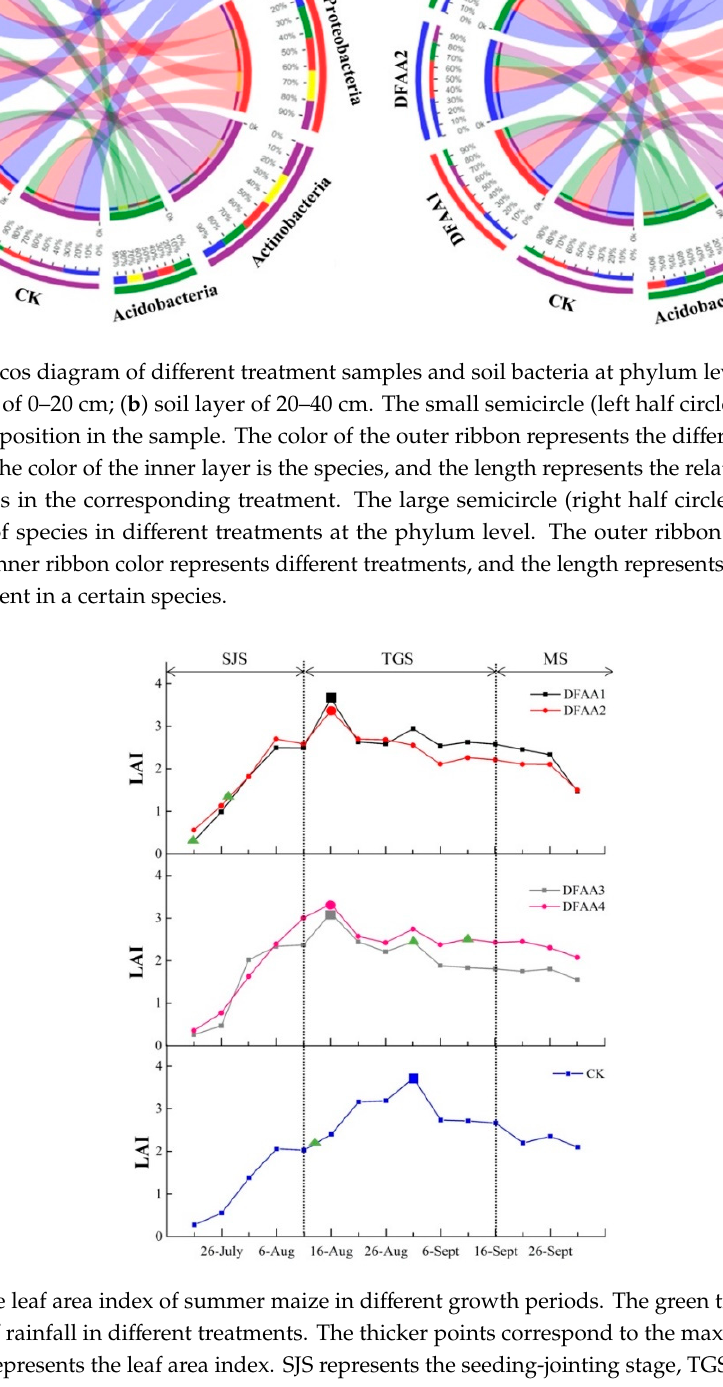
Figure 4. Circos diagram of different treatment samples and soil bacteria at phylum level after DFAA. ( a ) Soil layer of 0–20 cm; ( b ) soil layer of 20–40 cm. The small semicircle (left half circle) indicates the bacteria composition in the sample. The color of the outer ribbon represents the different treatments, from which the color of the inner layer is the species, and the length represents the relative abundance of the species in the corresponding treatment. The large semicircle (right half circle) indicates the proportion of species in different treatments at the phylum level. The outer ribbon represents the species, the inner ribbon color represents different treatments, and the length represents the proportion of the treatment in a certain species.